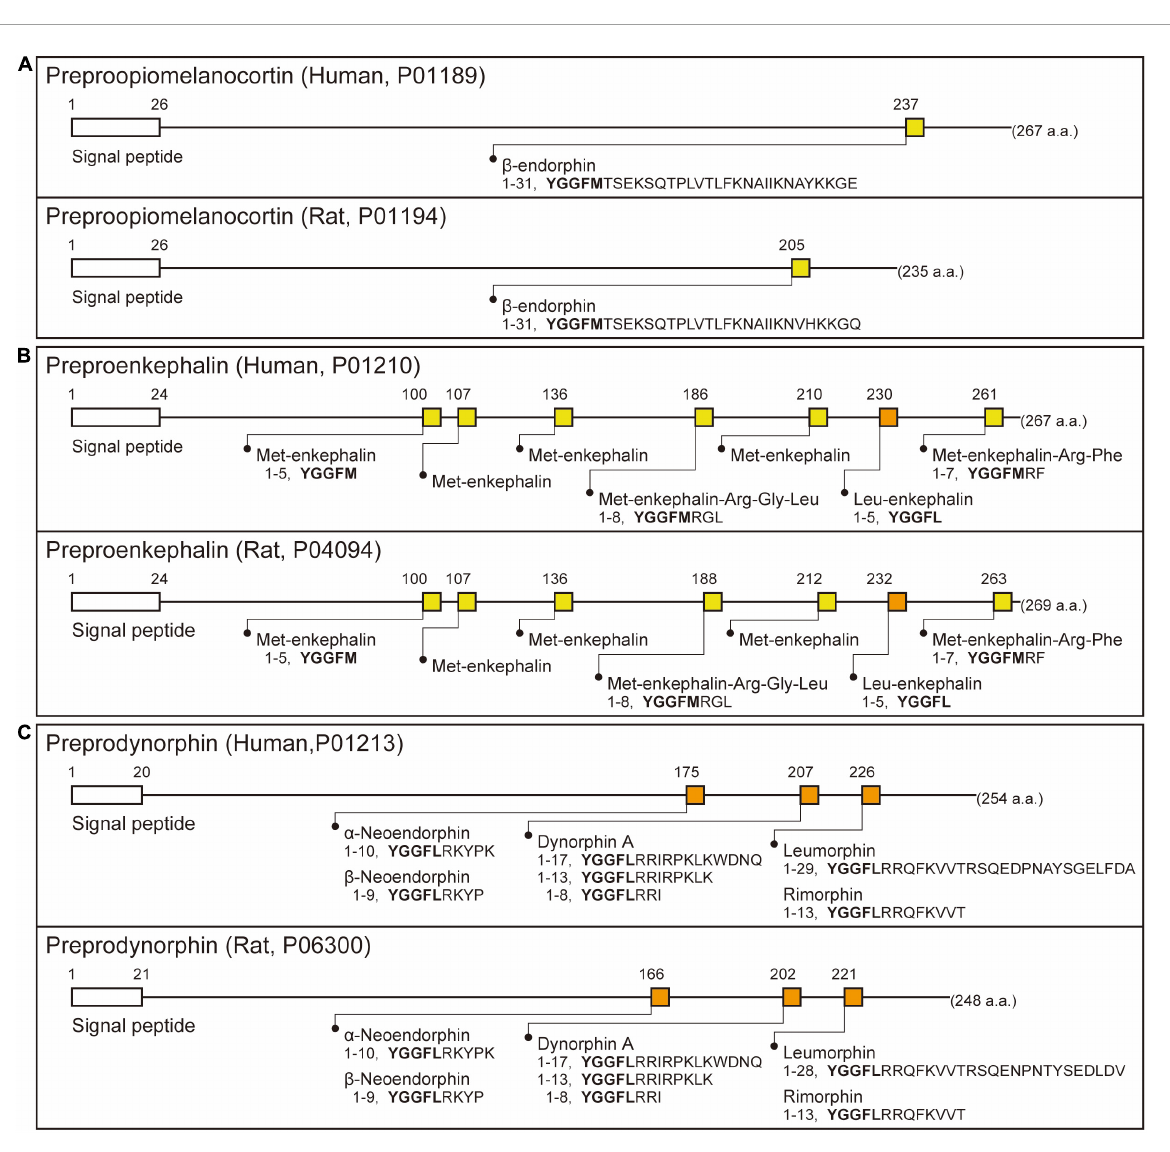
FIGURE2 Schematic illustration of β -endorphin, Met- and Leu-enkephalins, and the dynorphin family (dynorphin A, α - and β -neoendorphins, leumorphin, and rimorphin) in their precursors in humans and rats based on UniProtKB (https://www.uniprot.org/uniprot/). The precursors comprise a signal peptide at the N-terminal. (A) β -Endorphin consists of 31 amino acids cleaved from the precursor preproopiomelanocortin in humans and rats. Note that the five N-terminal amino acids (YGGMF, yellow squares) of β -endorphin, identical to Met-enkephalin, are commonly found in the mammals examined. (B) Met- (YGGMF, yellow squares) and Leu-enkephalins (YGGML, orange squares) consist of five amino acids cleaved from the precursor preproenkephalin. Note that human and rat preproenkephalin possess six Met-enkephalin and one Leu-enkephalin motifs, and two of six Met-enkephalin motifs are processed to eight or seven amino acid peptides (Met-enkephalin-Arg-Gly-Leu and Met-enkephalin-Arg-Phe). (C) Dynorphin A, α - and β -neoendorphins, leumorphin, and rimorphin (also known as dynorphin B) consist of 8–28 amino acids cleaved from the single precursor preprodynorphin. Note that the five N-terminal amino acids (YGGML, orange squares) of all dynorphin family peptides are identical to Leu-enkephalin. The amino acid sequence of dynorphin A is identical among the mammals